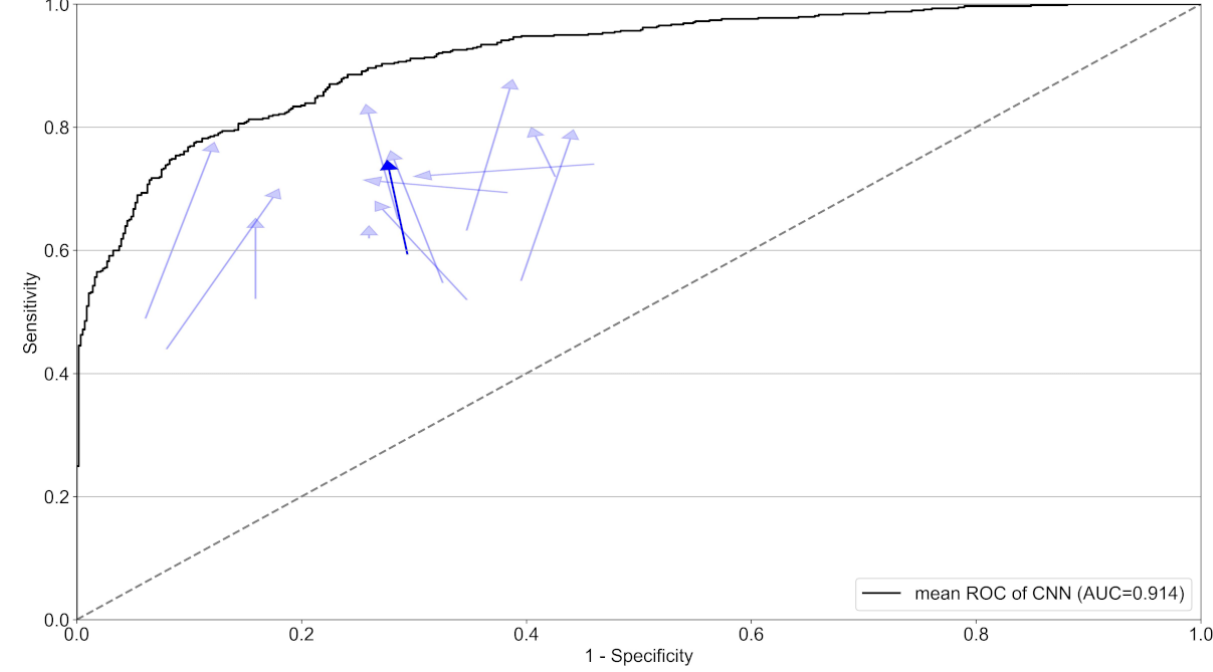
Figure 2. Combined and individual dermatologists’ diagnostic accuracy without and with artificial intelligence (AI) support. Diagnostic accuracy is measured using sensitivity and specificity. Arrows represent the change in the diagnostic accuracy from without AI support to with AI support. Highlighted arrows represent the participants combined. In addition, the black curve denotes the mean receiver operating characteristic curve of the classifier. ROC: receiver operating characteristic; CNN: convolutional neural network; AUC: area under the